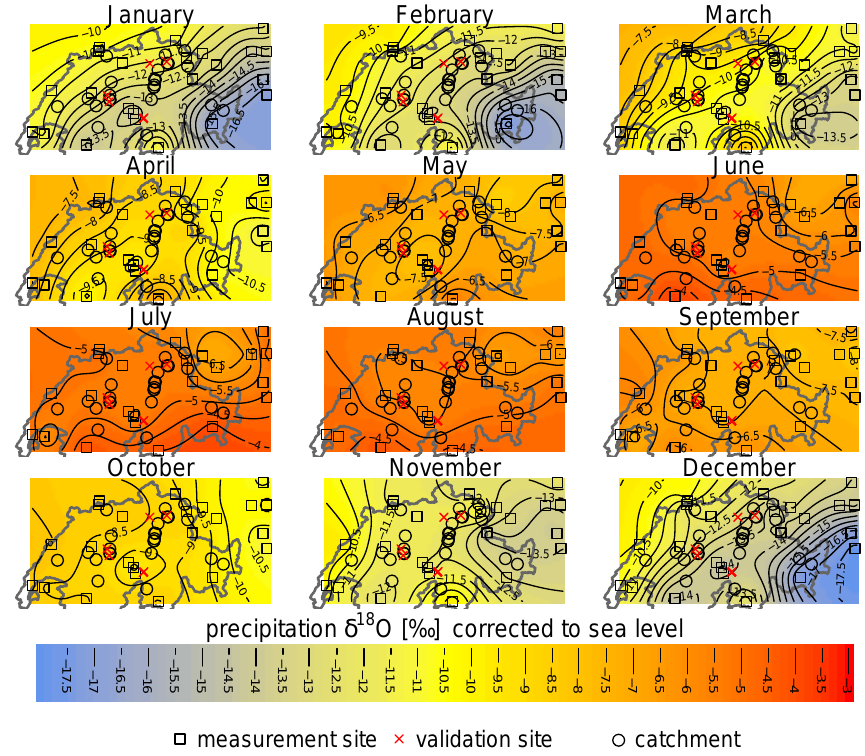
Figure 3. Monthly maps of interpolated sea level precipitation δ 18 O